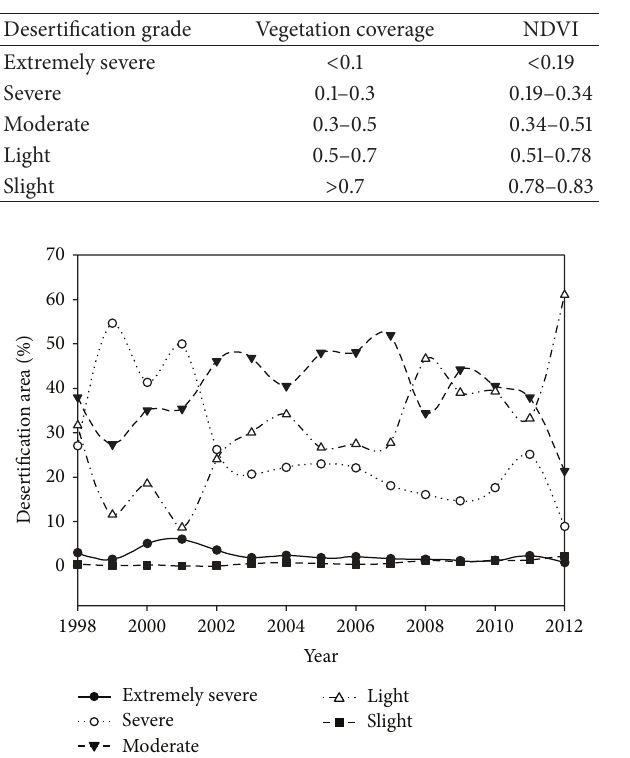
Table 1: Gradation standard for land desertification.